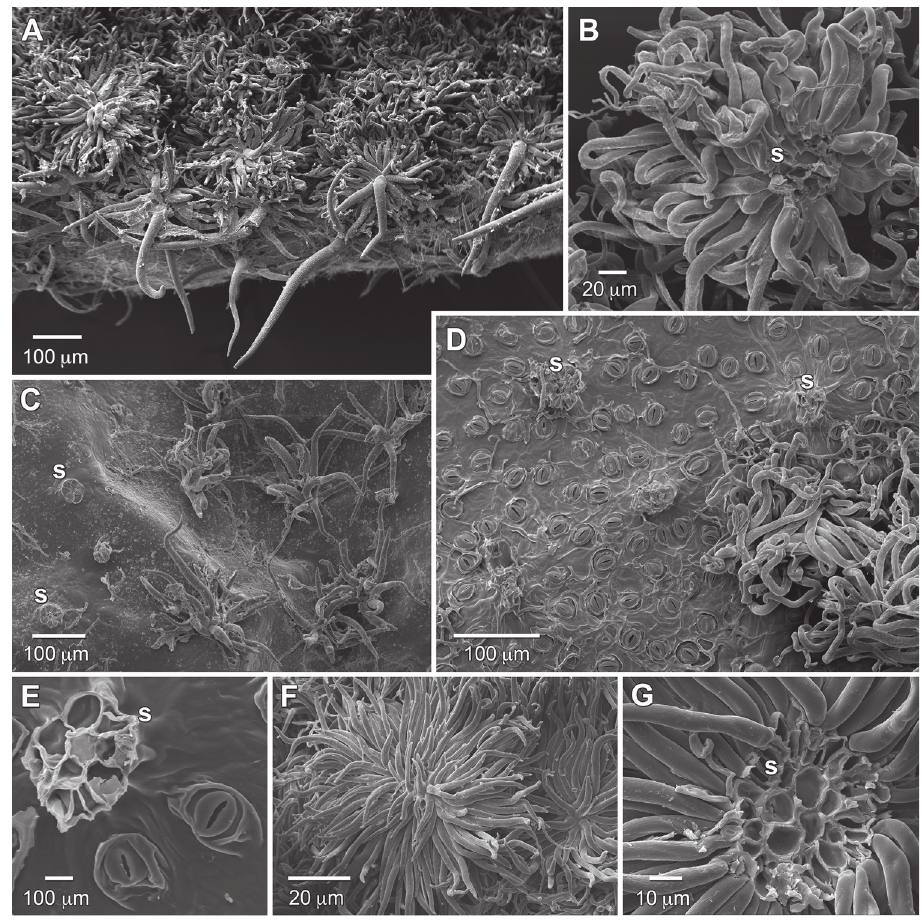
Figure 3. Trichome and leaf surface comparisons of Raveniopsis microphyllus ( A–E ) and R. breweri ( F–G ). A Abaxial side of leaflet showing trichomes transitioning from rosulate to porrect-multiradiate with central long radii at margin (sampled from proximal margin of lateral leaflet) B Back of rosulate trichome showing central multicellular attachment stalk, and curled free arms C Adaxial side of young leaflet showing multiradiate trichomes, and rosette bases of trichomes that have weathered off D Abaxial side of leaflet with most trichomes removed to show dense stomata and stalk bases of rosulate trichomes; note fungal hyphae on epidermis E Close-up of stomata and stalk base of rosulate trichome F Raveniopsis breweri abaxial trichome G Back of Raveniopsis breweri abaxial trichome, showing central multicellular attachment stalk. (Abbreviations: s = stalk. Source: R. microphyllus , A–E Tripp 3191 , US; R. breweri , F–G Prance & Huber 28254 ,